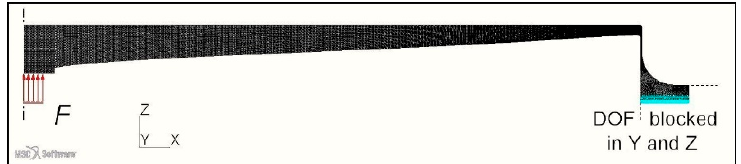
Figure 11. Drawing section, in ( x , z ) plane, of the VCM front part showing the degree-of-freedom (DOF) boundaries. These conditions applies to the previous FEA modeling as blocked , i.e., non-movable, in the axial and tangential directions, i.e., z and y and is free to move in the x -direction. The force F = 10 daN is applied over ρ ≤ 0.03125, i.e., 0.25 mm radius area.